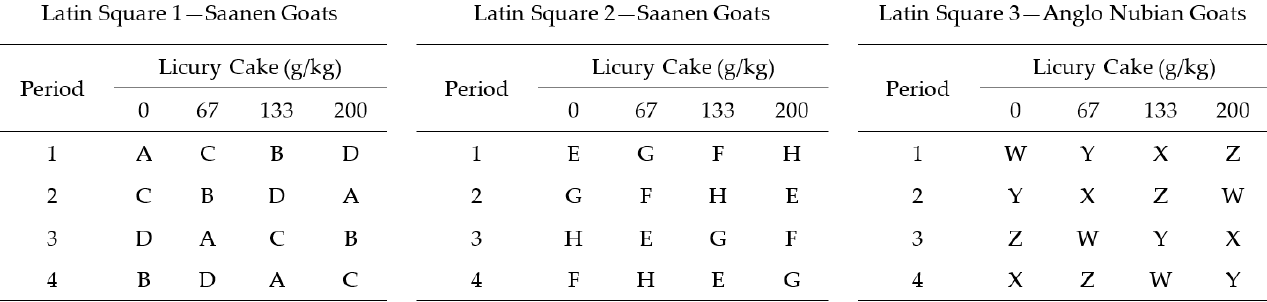
Table 1. Proportion of ingredients and analyzed chemical composition of the diets including licury cake.